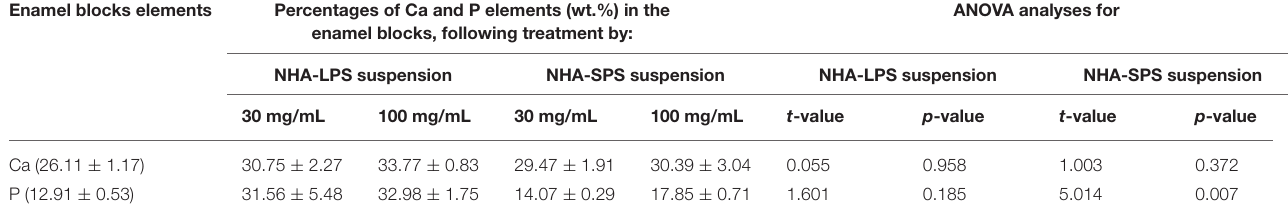
TABLE 4 | Mean values (wt. %) of Ca and P elements in the initial caries like lesions induced in the enamel blocks and treated by NHA suspensions for 10 days, as well as the statistical analysis recorded by ANOVA test. Enamel blocks elements